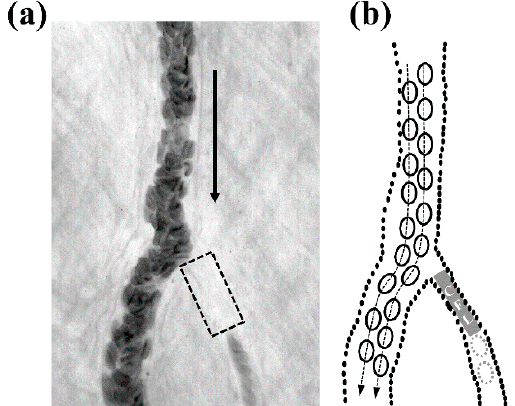
Figure 1. In vivo observation of plasma skimming at an arteriolar bifurcation ( a ); And its corresponding schematic depicting the red blood cell (RBCs) flow trajectory ( b ); Dashed and solid arrows indicate the cell trajectory and flow direction, respectively. Dashed cells indicate an absence of RBCs in the daughter branch. Plasma from the cell-free layer (CFL) can be observed to skim off into the daughter branch.